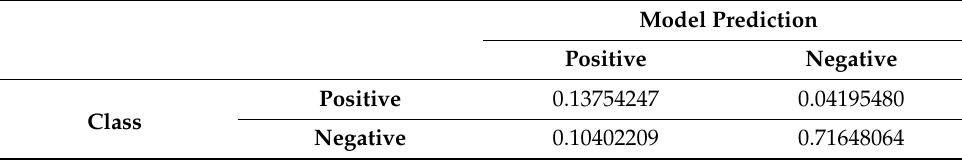
Table 8. Confusion matrix (Improved U-Net #1/ large number of particles).